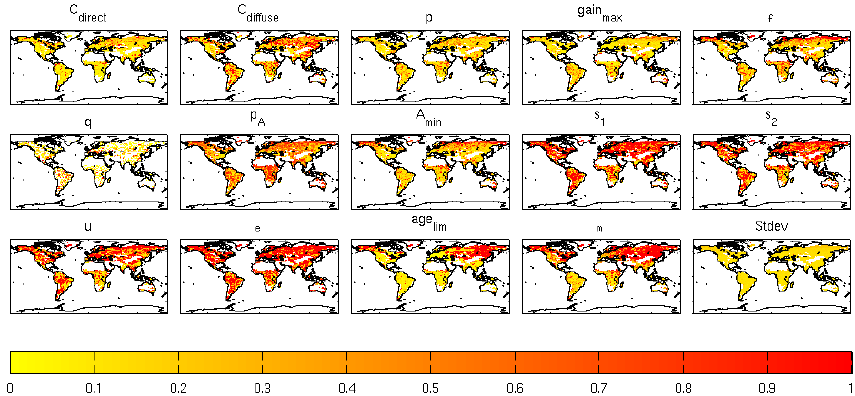
Fig. A4. Relative 95% confidence intervals for all parameters derived from the posterior distribution. For parameter descriptions see Tables 1 and 2 and Sect. 2 in the main